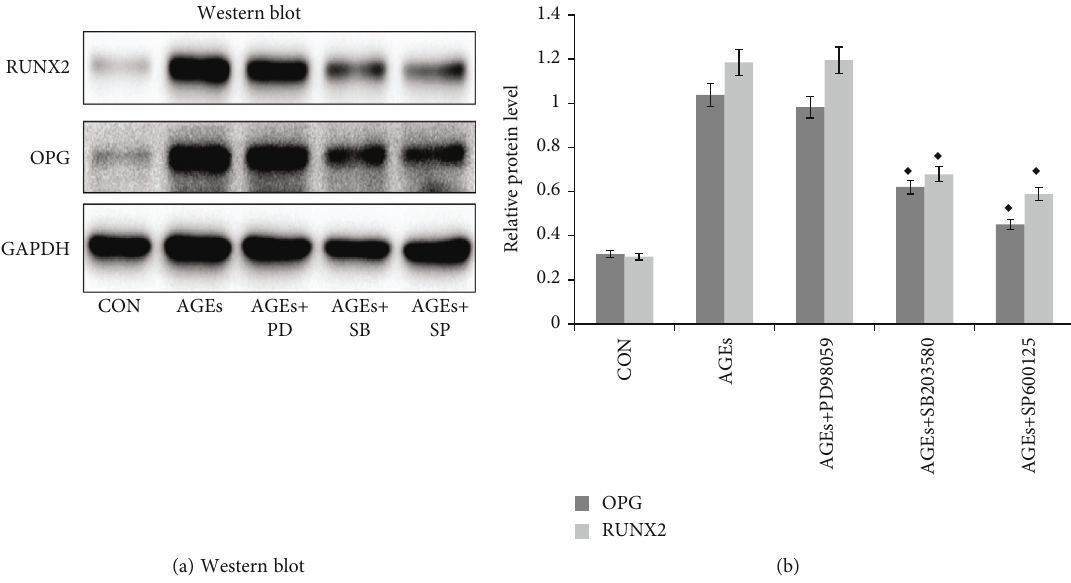
Figure 8: SB203580 and SP600125 prevent AGE-induced upregulation of RUNX2 and OPG in EPCs. EPCs were pretreated 24 h with PD98059 (50 μ mol/l), SB203580 (20 μ mol/l), or SP600125 (50 μ mol/l) followed by treatment with 100 μ g/ml AGE for 7 days. Cells that were not exposed to inhibitor or AGE were used as the negative controls. Cells that were exposed to AGE but not to inhibitor were used as the positive control for all AGE experiments. (a) Protein expressions of RUNX2 and OPG were detected by western blotting and (b) the levels were semiquantitated by densitometric analysis; GAPDH was used as a loading control. Each data point represents the results of three independent experiments. ♦ P < 0 : 05 vs. AGE-treated samples. AGE: advanced glycation end product; CON: control; EPC: endothelial progenitor cell; OPG: osteoprotegerin; PD: PD98059; RUNX2: runt-related transcription factor 2; SB: SB203580; SP: